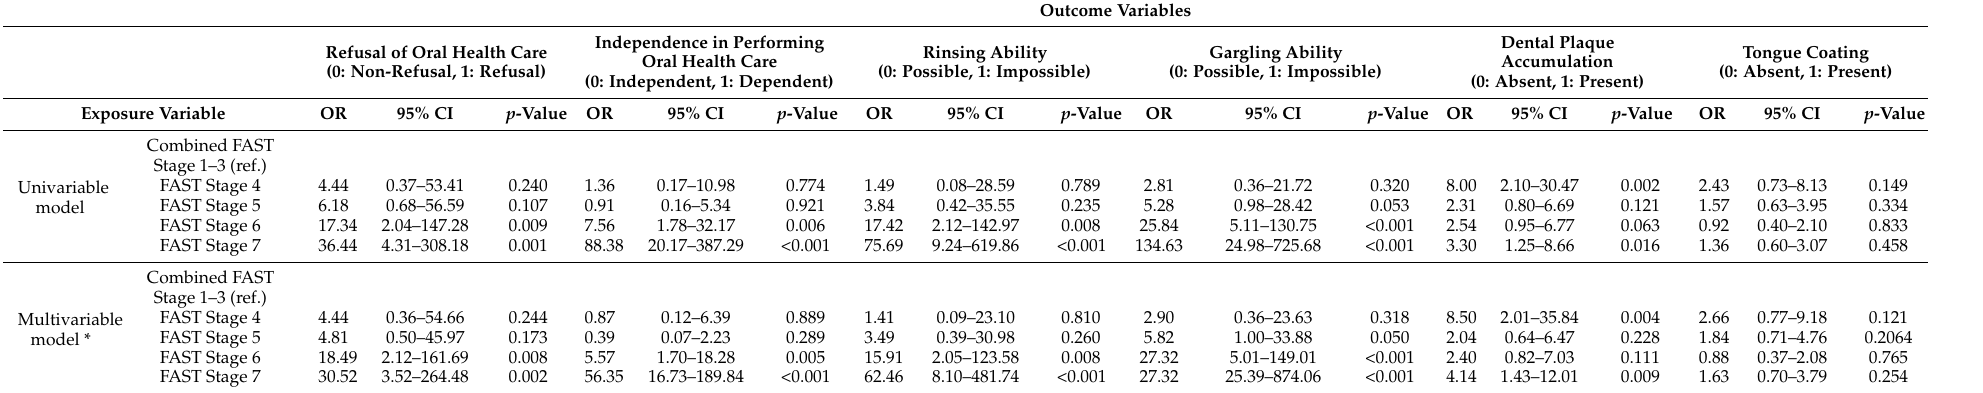
Table 2. Odds ratios for oral hygiene management issues and oral health status according to